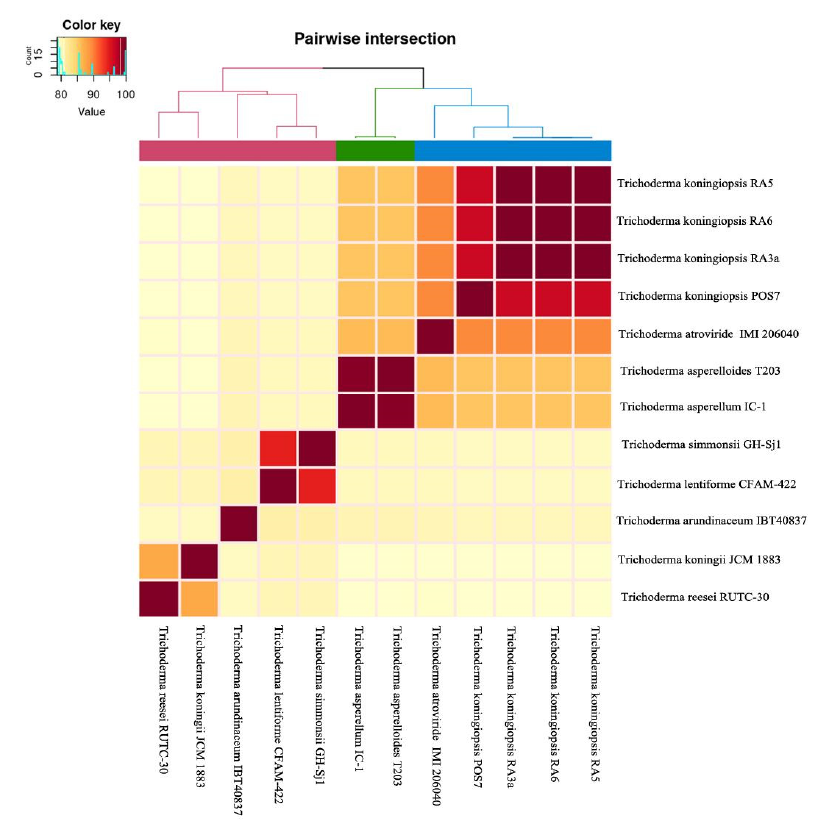
Figure 6. The ANI values based on the FastANI algorithm for Trichoderma spp. related genomes. The clustering was done based on a Euclidean distance matrix.